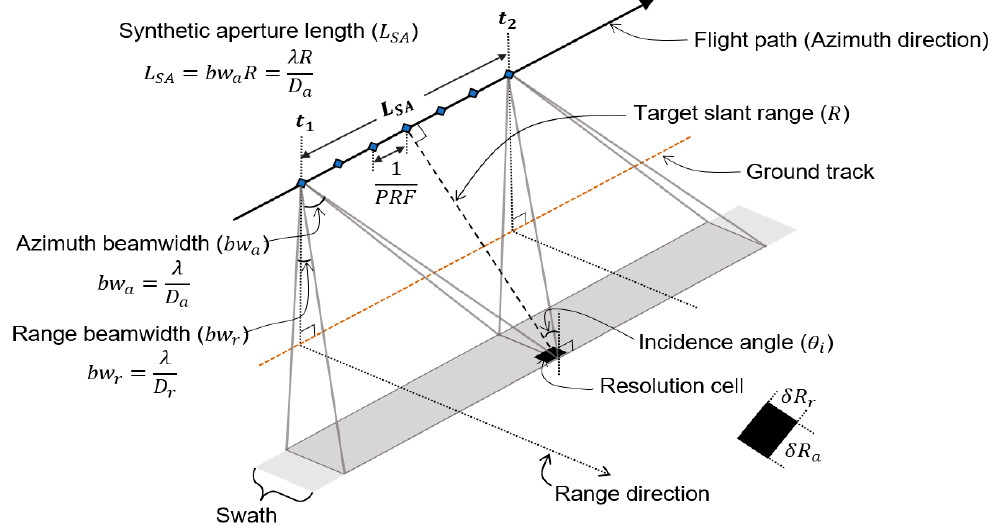
Figure 1. Geometry of SAR imaging.